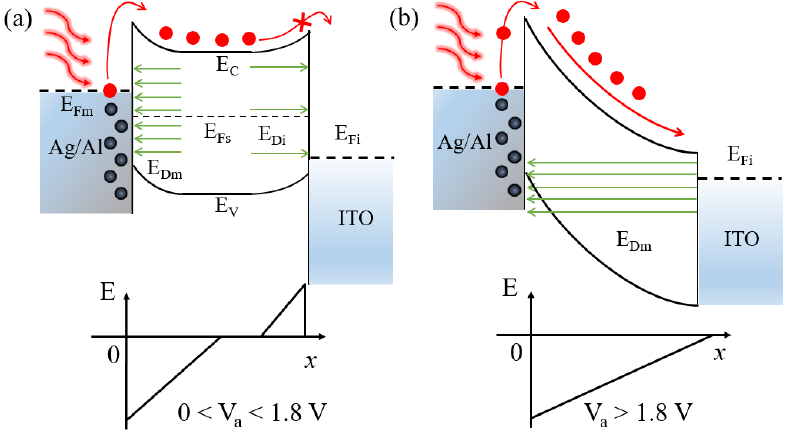
Figure 5. Schematic energy level diagrams of the plasmonic OPD under forward bias below 1.8 V ( a ) and above 1.8 V ( b ), when the illumination is on at the wavelength beyond the Alq 3 absorption band.